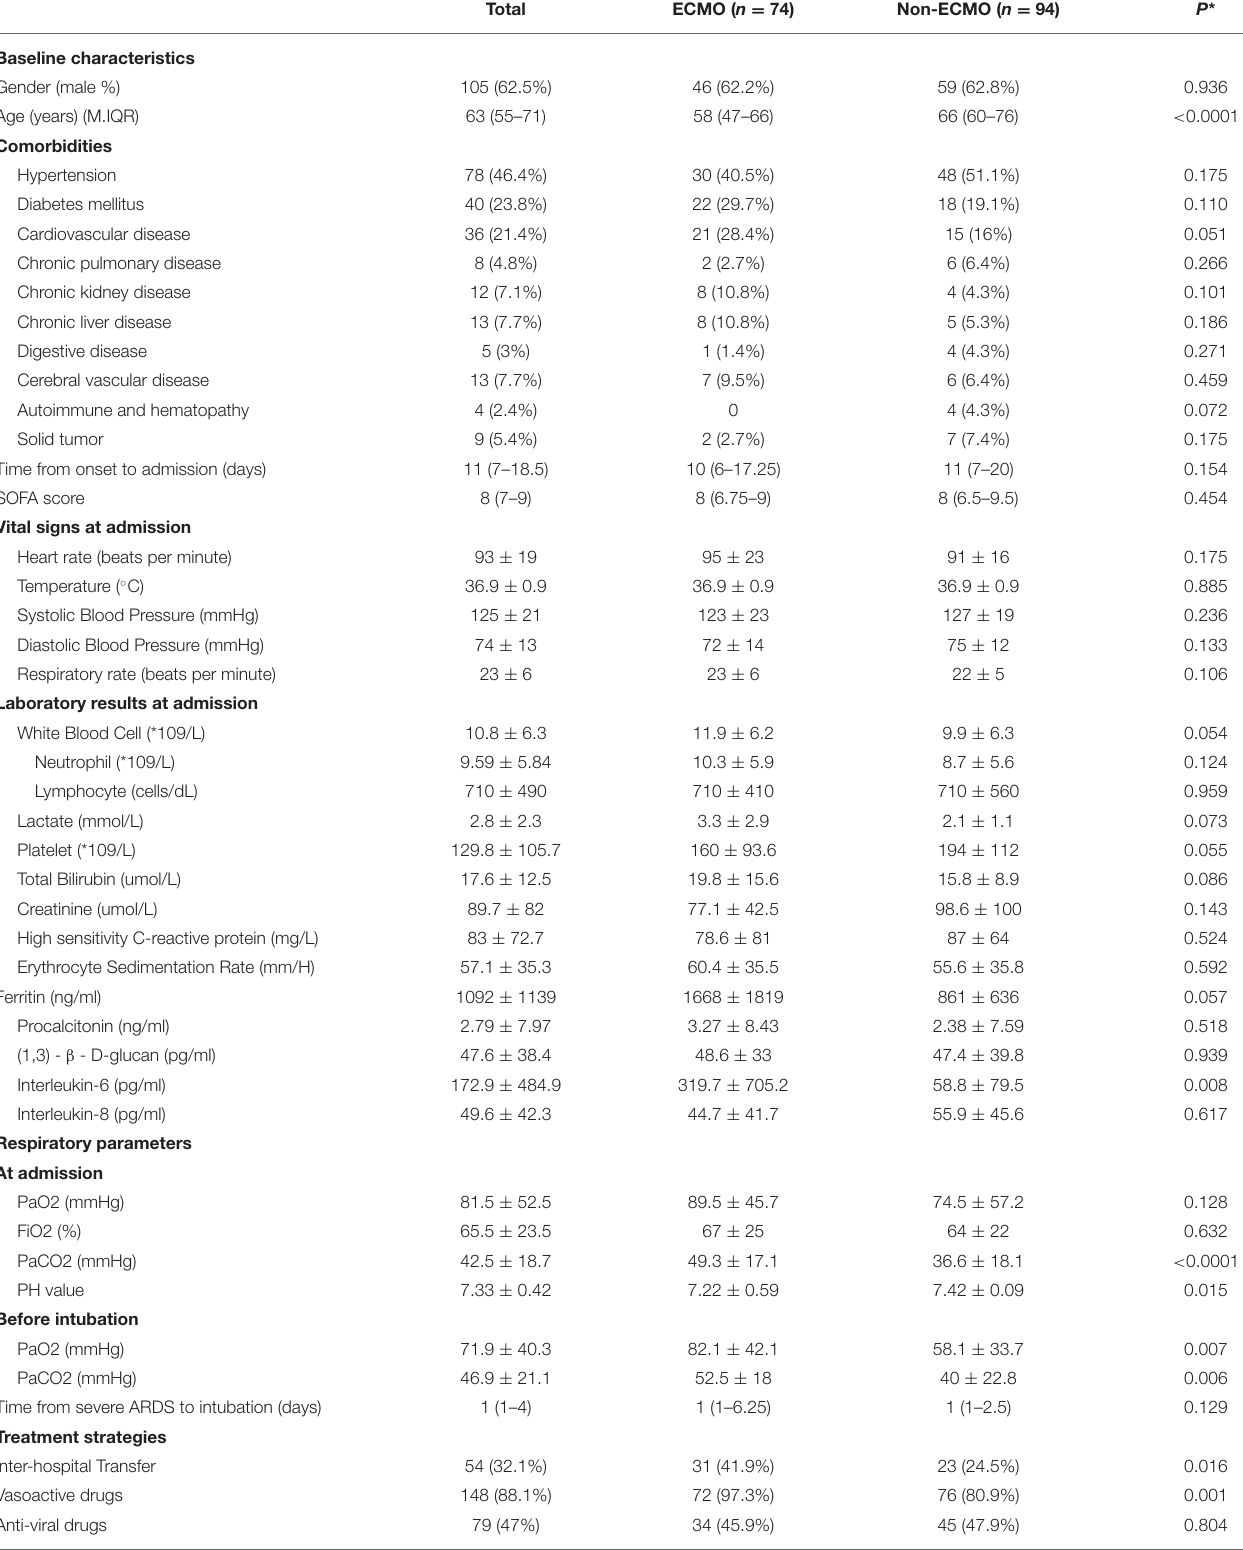
TABLE 1 | Comparison between ECMO and non-ECMO patients. Total ECMO ( n = 74) Non-ECMO ( n = 94) P